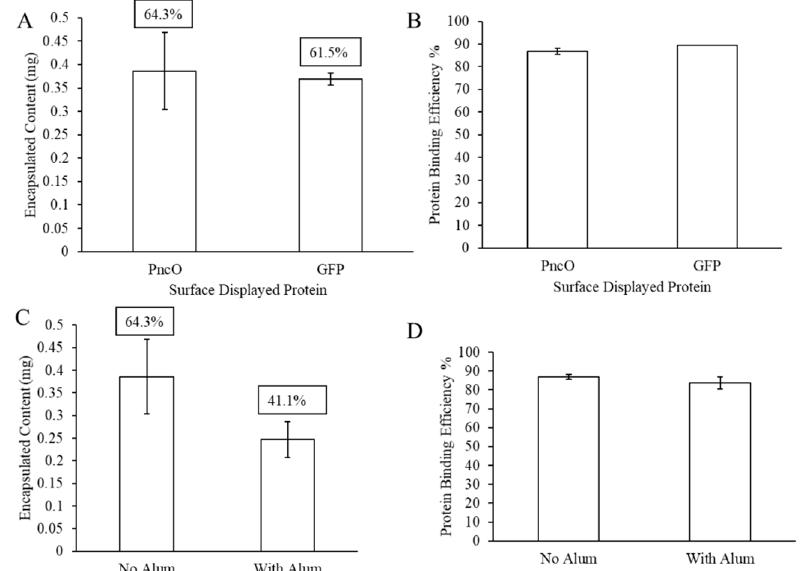
Figure 6. LEPS formulation with a virulent-specific pneumococcal disease protein antigen (PncO) surface protein attachment. Assessment of polysaccharide 3 encapsulation and surface protein binding efficiency compared to GFP ( A , B ) and with alum ( C , D ). Figure 7 and Table 1 present liposomal size distribution and zeta potential values, respectively.